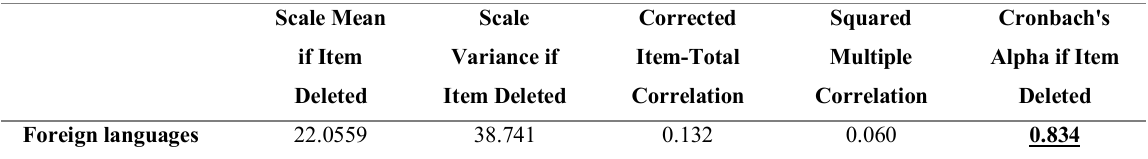
Figure 3: Stated importance on the knowledge of foreign languages Table 1: Item-total statistics for LIKERT scale variables